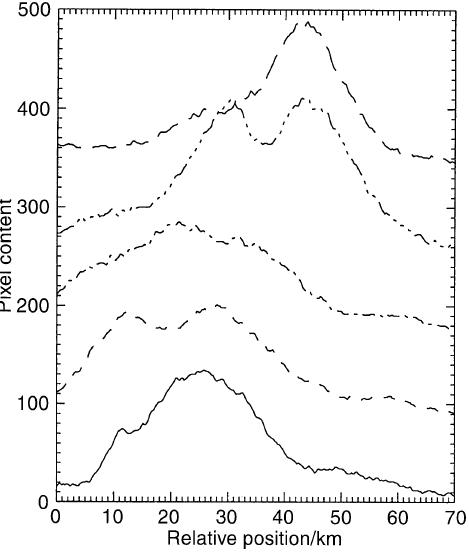
Fig. 6. South-north brightness profiles along the scan direction through the arcs in 1-min steps beginning 19:40:25 from bottom to top . The profiles are shifted for better